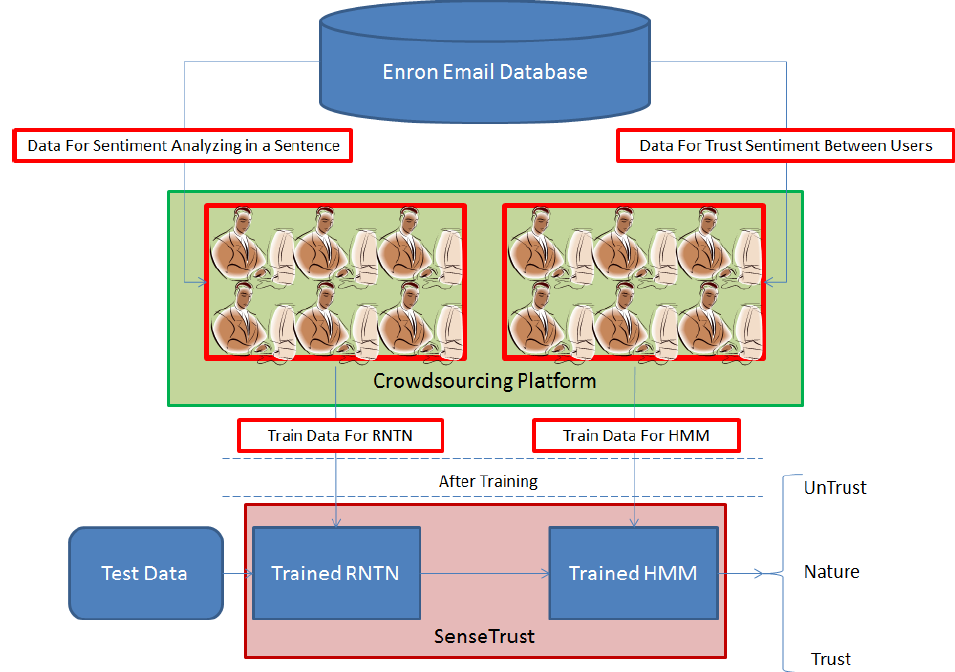
Figure 6. SenseTrust Schema.